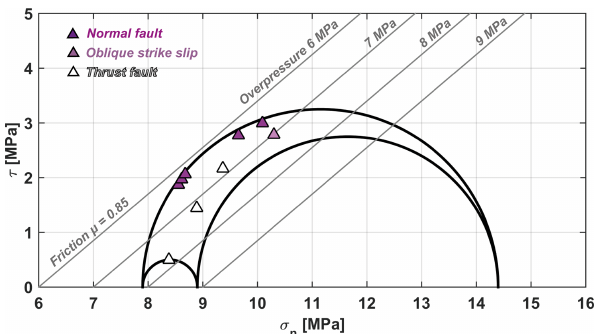
Figure 14. Mohr–Coulomb diagram representing the stress field es- timate by Krietsch et al. (2017) as Mohr circles (including hydro- static pressure of 0.6MPa). The failure limits assuming a friction coefficient of 0.85, no cohesion and overpressures of 6, 7, 8 and 9MPa are shown. For the focal mechanisms in Fig. 11 the nor- mal stress and shear stress are computed for the focal plane that requires the smallest overpressure (above hydrostatic) to reach fail- ure. All selected focal planes fail for overpressures of 7–9MPa. The focal planes for which stresses are represented are indicated in red in Fig.